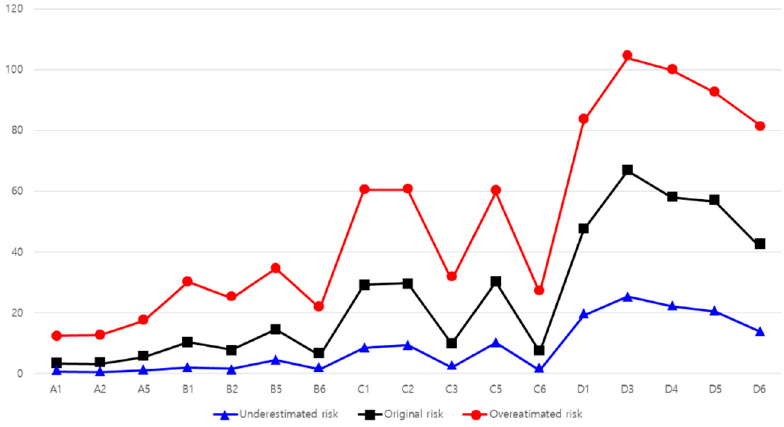
Figure 5. Sensitivity analysis on structural/job risks by work-risk type.